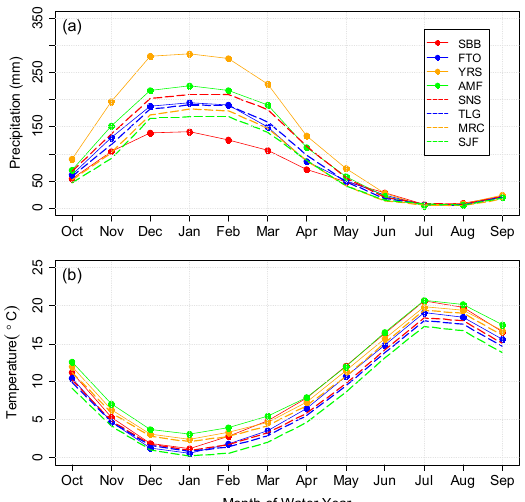
Figure 2. Long-term (water year 1916–2011) average monthly ( a ) precipitation and ( b ) mean temperature over four Sacramento Valley watersheds and four San Joaquin Valley watersheds.